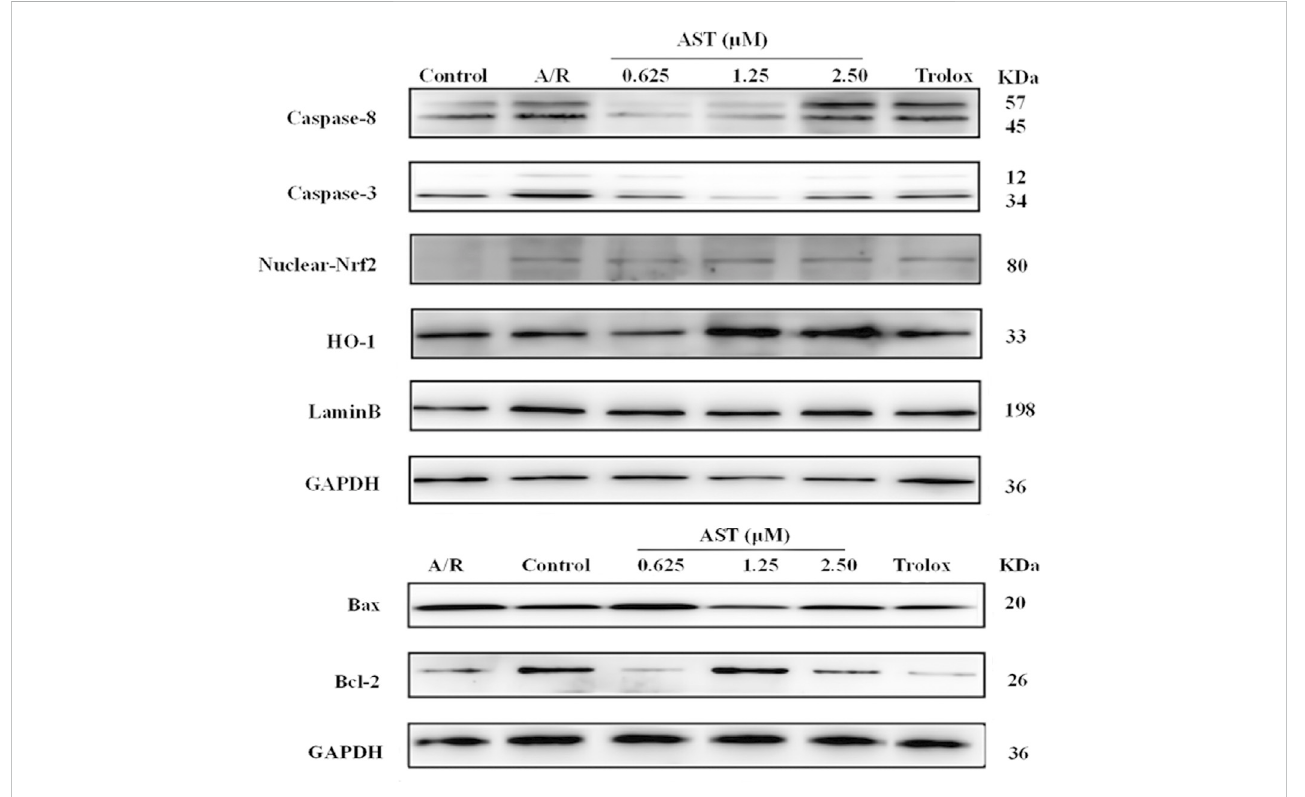
FIGURE 3 Immunoblots of protein content. A/R, anoxia reoxygenation; AST, astaxanthin.